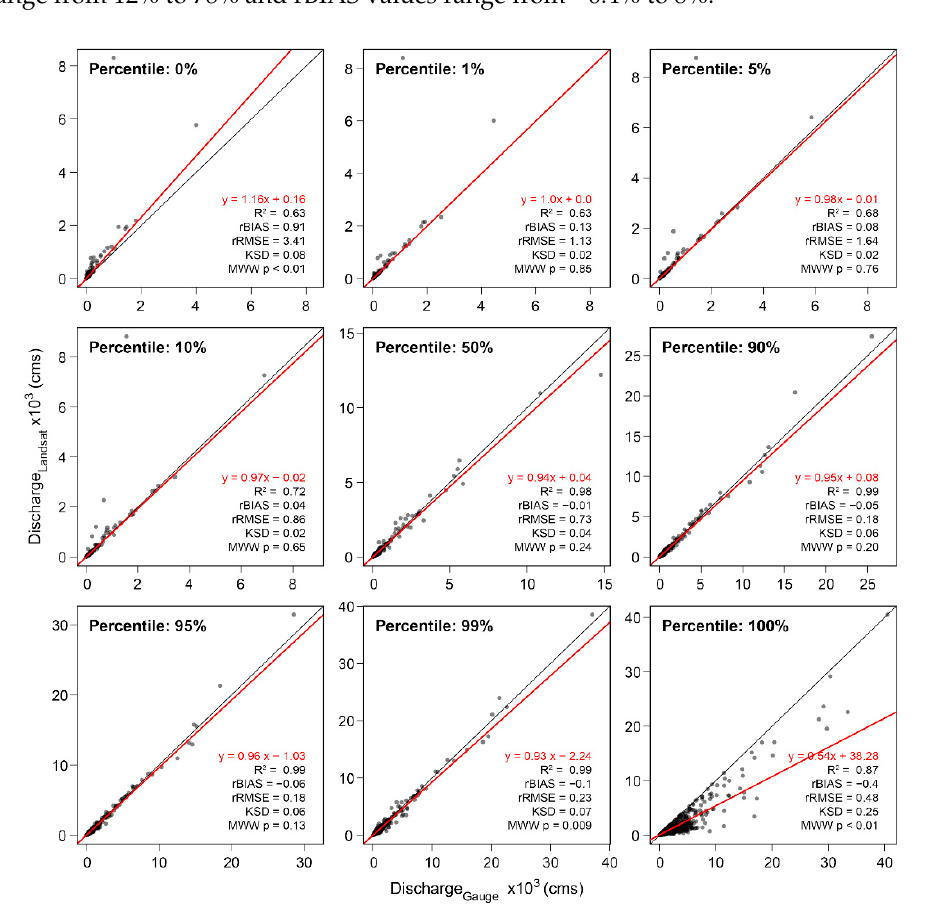
Figure 4. Full gauge record flow percentiles vs. Landsat-sampled flow percentiles for each USGS gauge studied (N = 1134). The black line represents the 1:1 line and the red line represents the Theil–Sen median estimator best fit (equation shown in red). R 2 : coefficient of determination; rBias: relative bias; rRMSE: relative root mean square error; KSD: Kolmogorov–Smirnov D-statistic; MWW p: Mann–Whitney–Wilcoxon p-value.